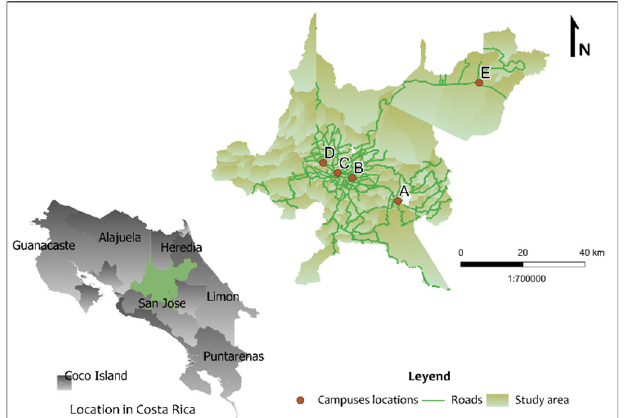
Figure 3. Location of the five campuses of the universities from the consortium (image developed by Mariajos é Esquivel, using Costa Rican Digital Atlas, 2014. Projection: CRTM05. Q GIS Software,